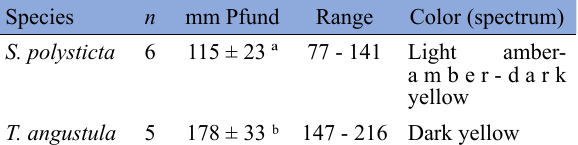
Table 3. Values of mm Pfund and color of samples (n) of honeys of S. polysticta and T. angustula (seven days after harvest; conservation at 4 ° C).